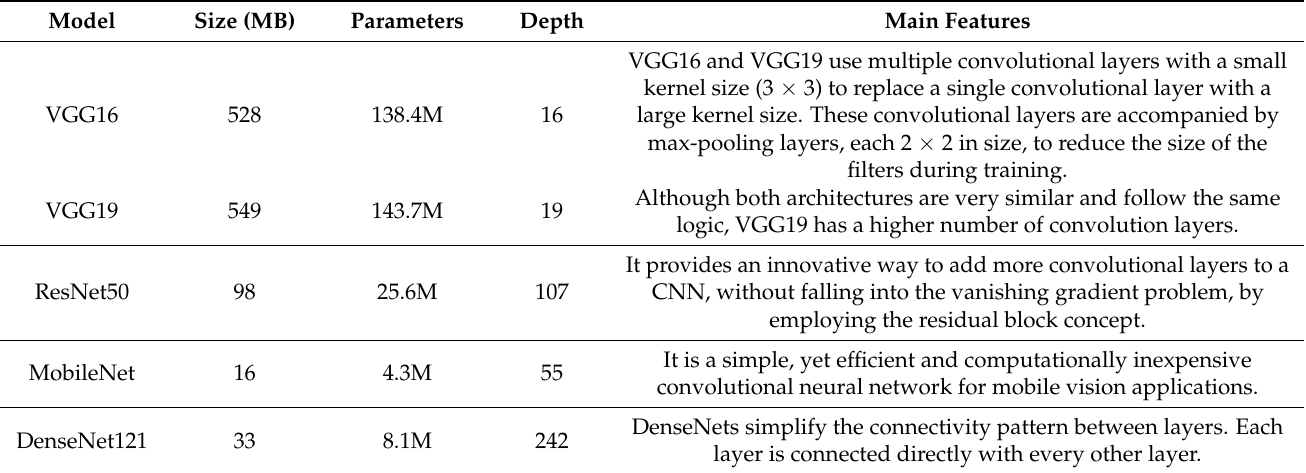
Table 3. Summary of Different Neural Network